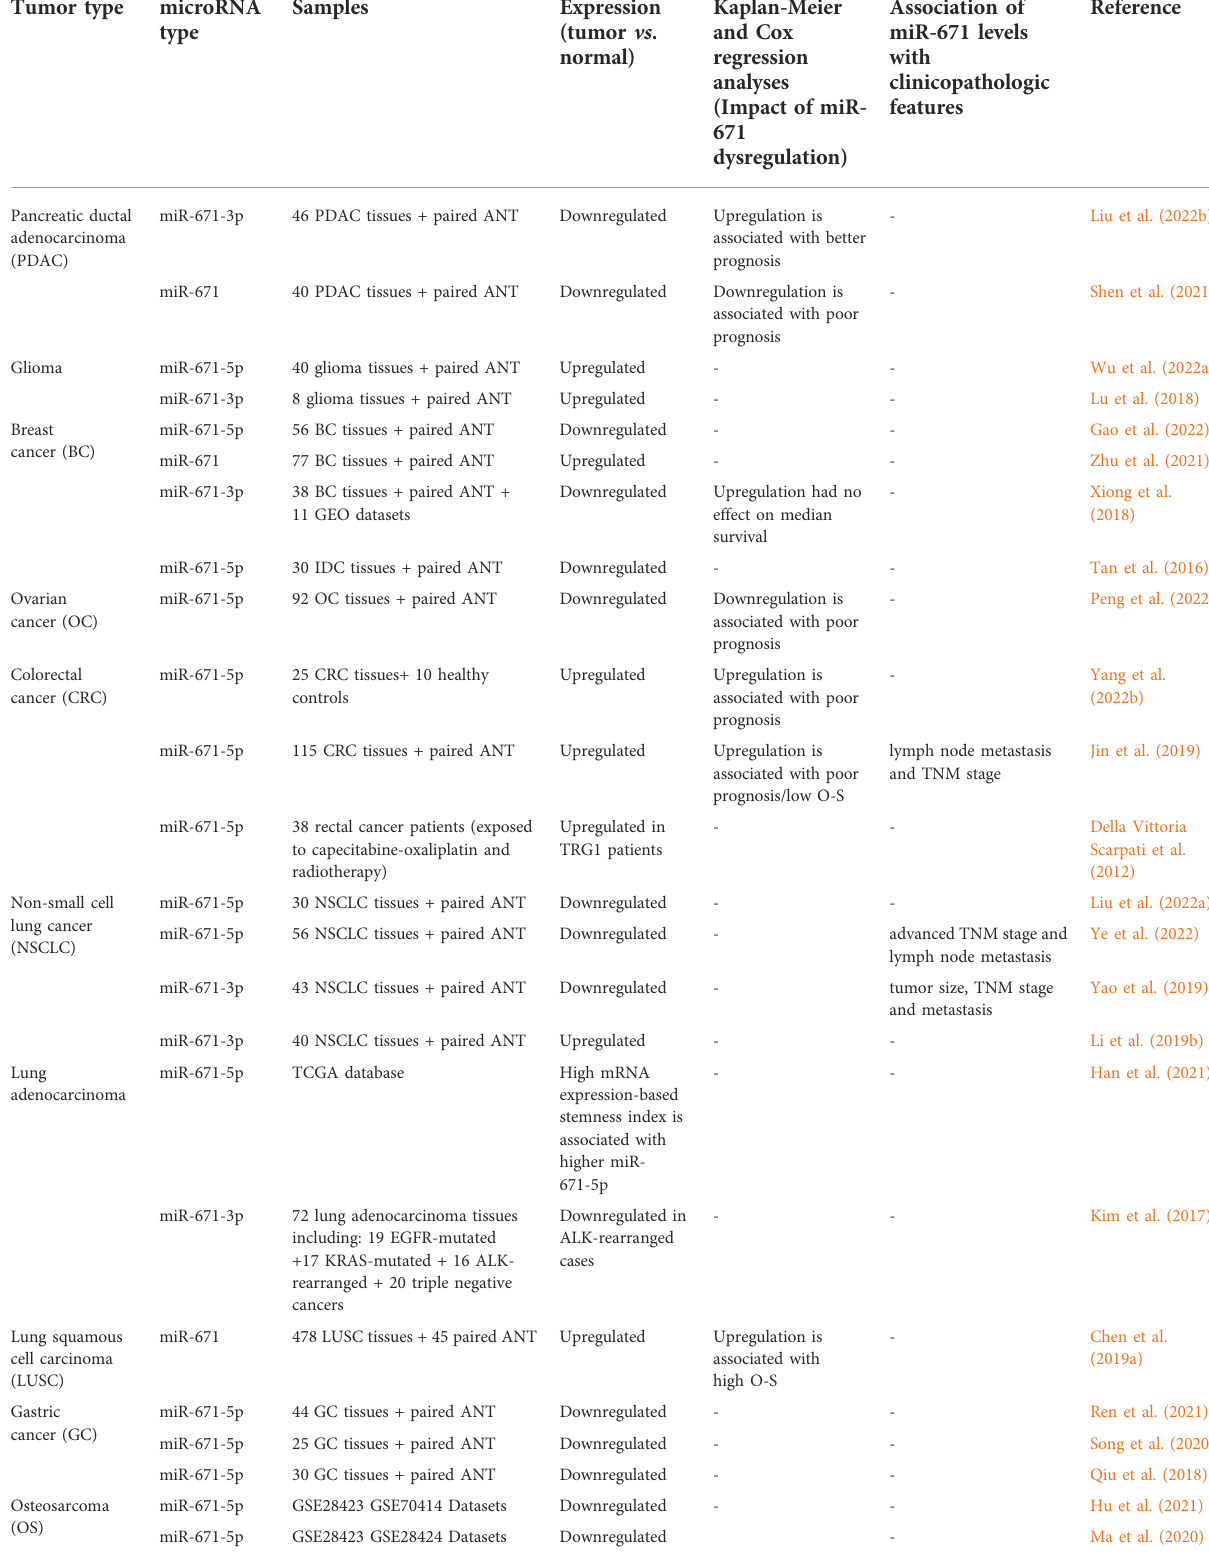
TABLE 3 Abnormal levels of miR-671 in clinical